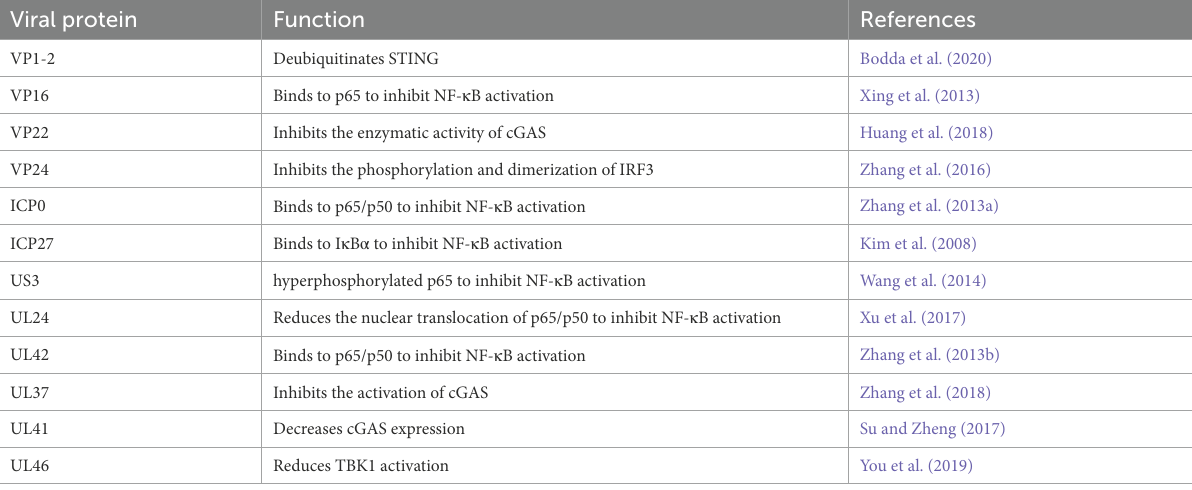
TABLE 1 Different viral proteins to suppress cGAS-stimulator of interferon genes (STING) pathway. Viral